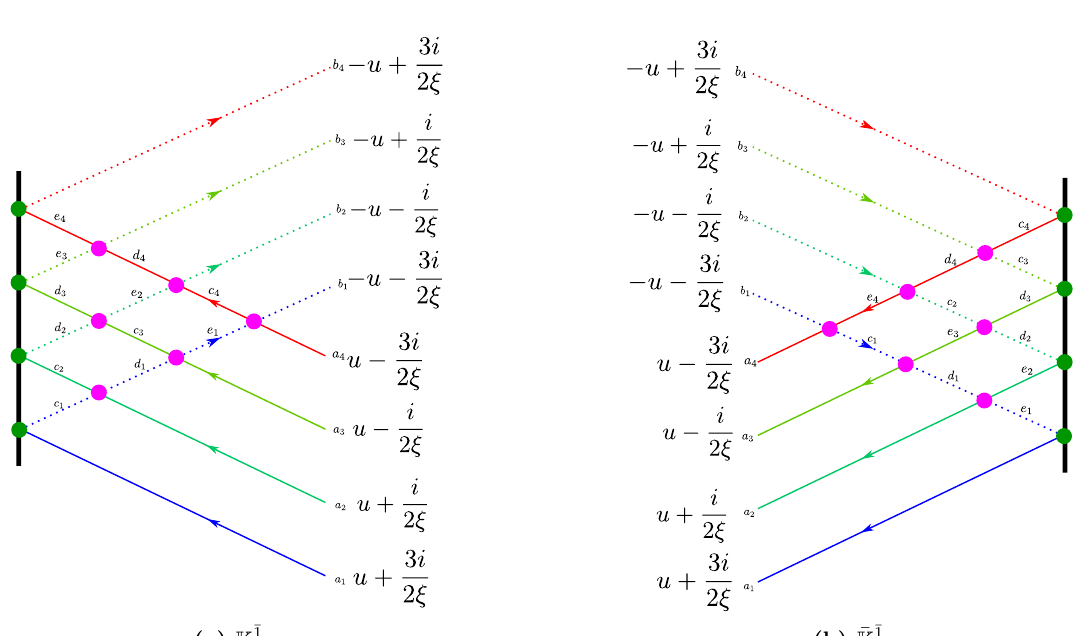
Figure 12. Fusion of the boundary reflection operators to obtain the quantum